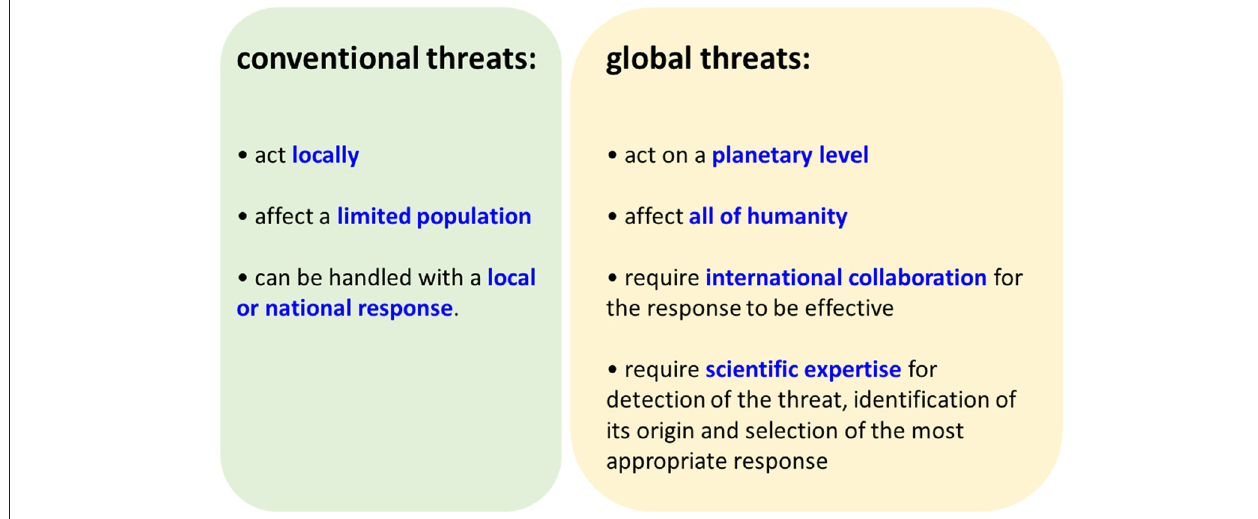
FIGURE 1 | Comparaison of conventional and global threats.